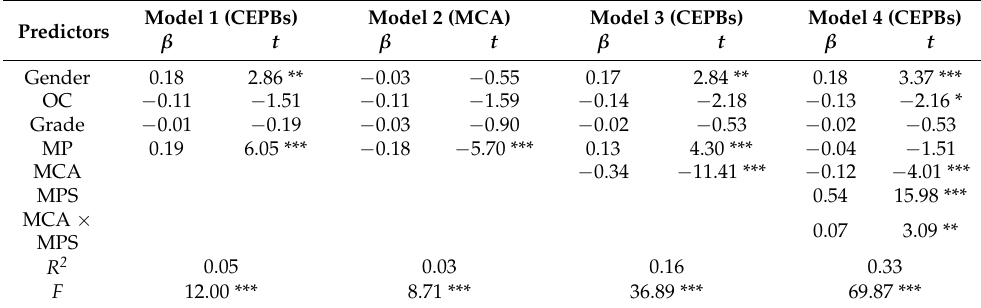
Table 2. Linear regression